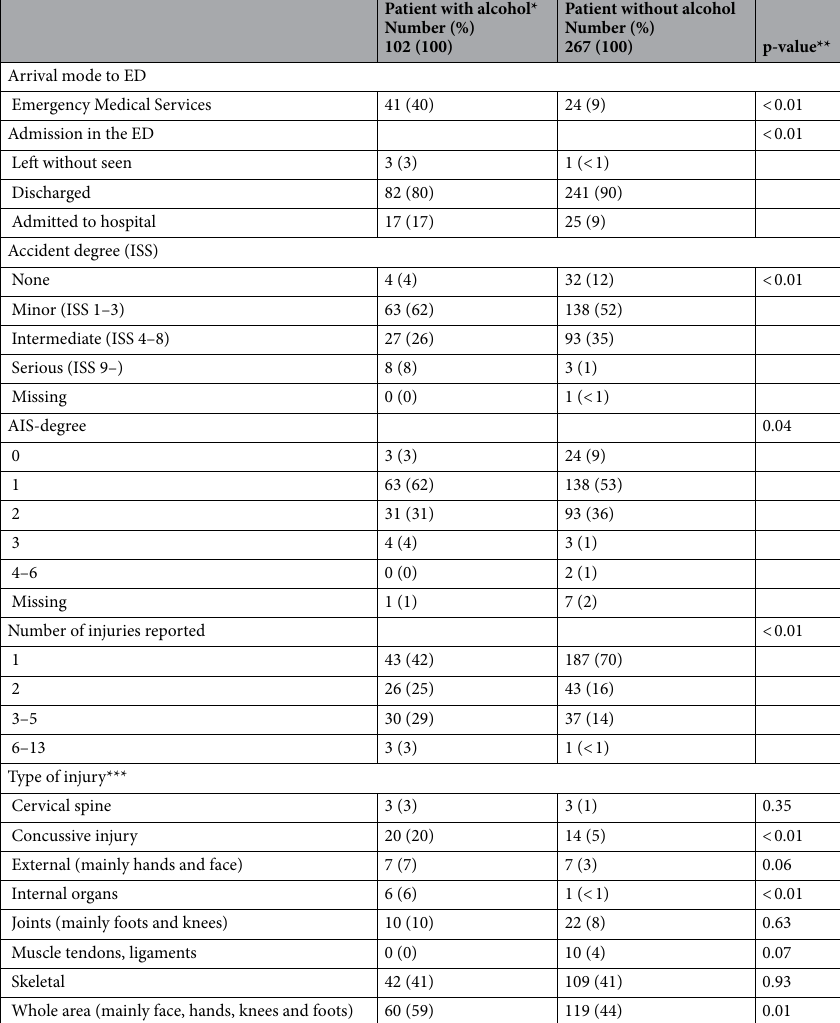
Table 2. Injury pattern of all patients visiting an emergency department due to an accident with an electric scooter in Stockholm, Sweden 2019–2020. *Alcohol in blood was determined as either a note of self-reported intake of alcohol in the medical file written by the physician or a value over 0 on the laboratory test serum- ethanol taken at arrival to the emergency department. **Chi squared test or Fischers 2-sided exact test if less than 5 per cell. ***Type of injury, all injuries without any upper limit of accidents per patient could be